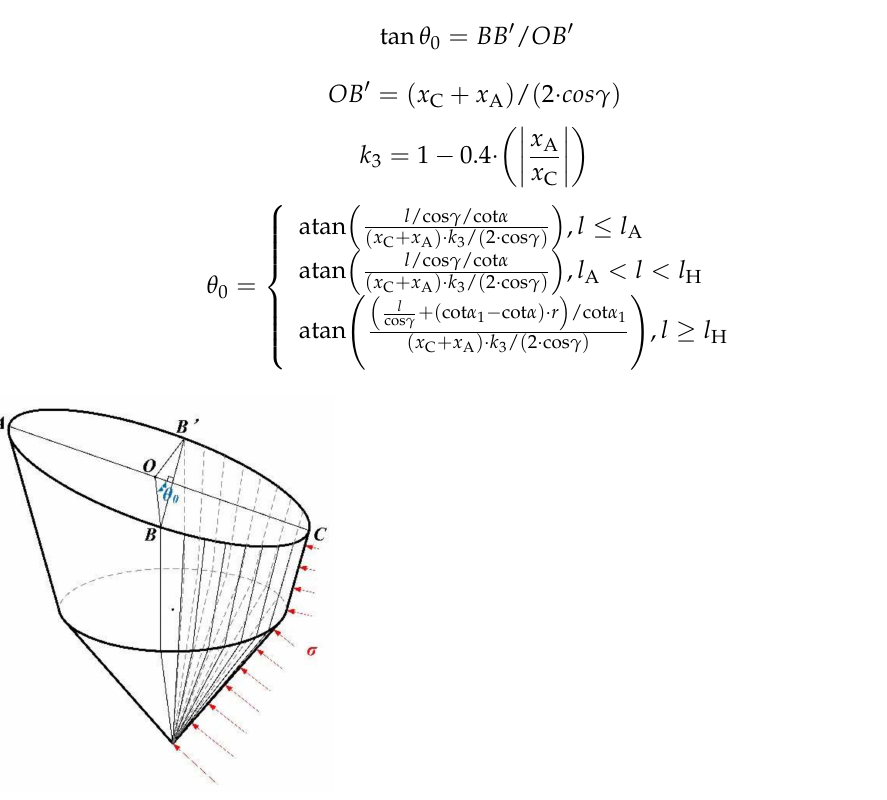
Figure 4. Schematic diagram of the force on the